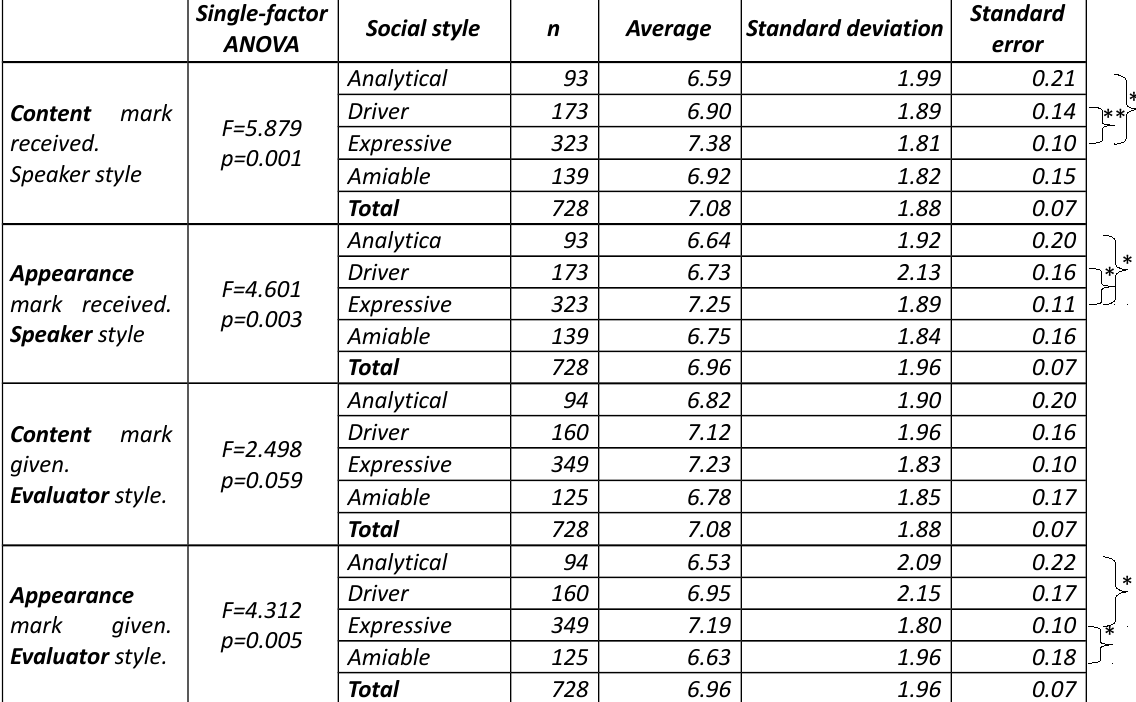
Table 1. Results of the single-factor variance analysis. Descriptive statistics of the sample and results of the single-factor ANOVA tests. A total of 728 content and appearance evaluations were included in the mean score comparisons, split by the social style of the evaluator and the speaker. Statistically significant differences in average marks were identified between social styles. The * sign indicates a difference in averages with a significance of p<0.05 corrected according to Bonferroni (n=120). The ** sign indicates a significance of p<0.01; with the same Bonferroni